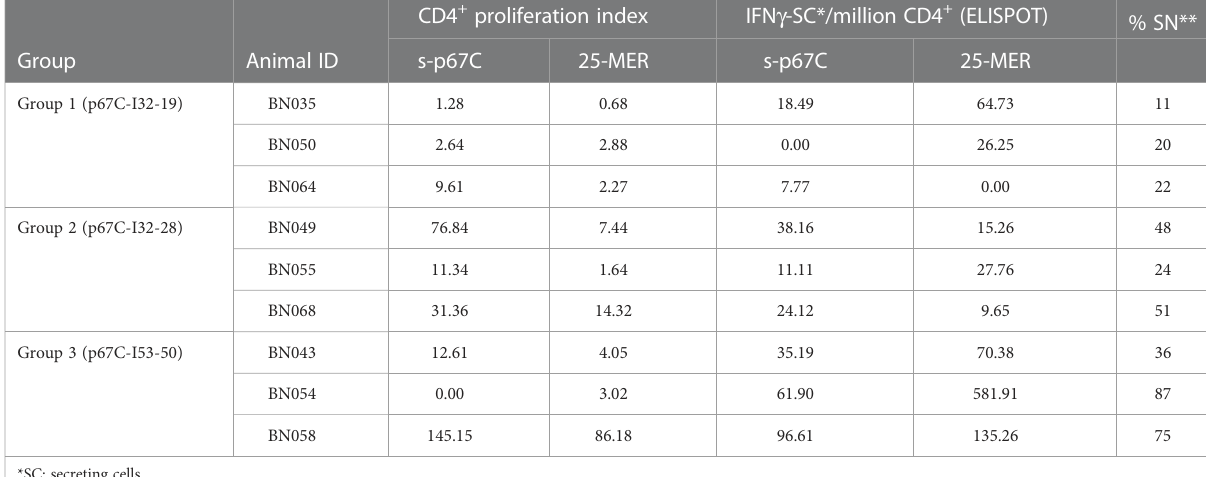
TABLE 3 Summary of CD4 + T-cell proliferation IFNg-ELISpot and seroneutralization assay results for immunogenicity studies on cattle.